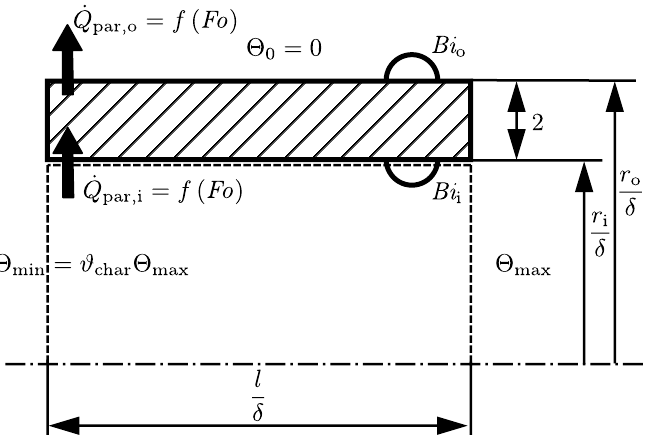
Figure 2. Non-dimensional parameters used for FEM simulation of the diabatic pipe